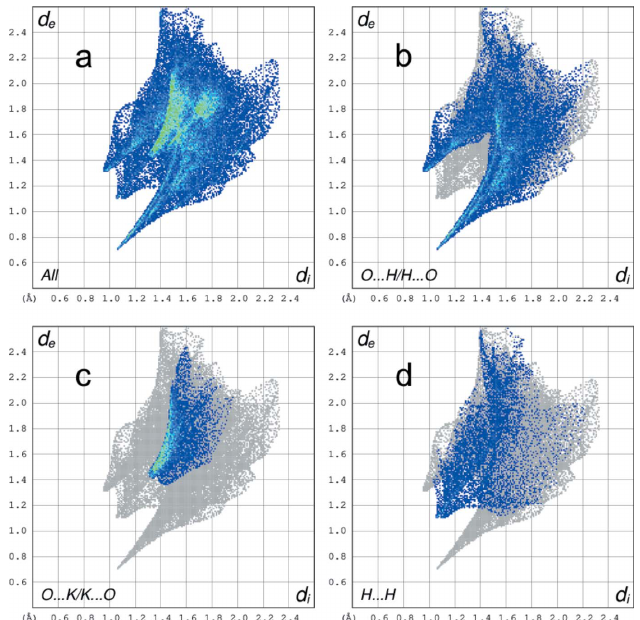
Figure 9 ( a ) Full two-dimensional fingerprint plot of the A complex anion (Ni1), and delineated into ( b ) O (cid:2)(cid:2)(cid:2) H/H (cid:2)(cid:2)(cid:2) O (41.3%) ( c ) O (cid:2)(cid:2)(cid:2) K/K (cid:2)(cid:2)(cid:2) O (15.8%) and ( d ) H (cid:2)(cid:2)(cid:2) H (13.7%) contacts.